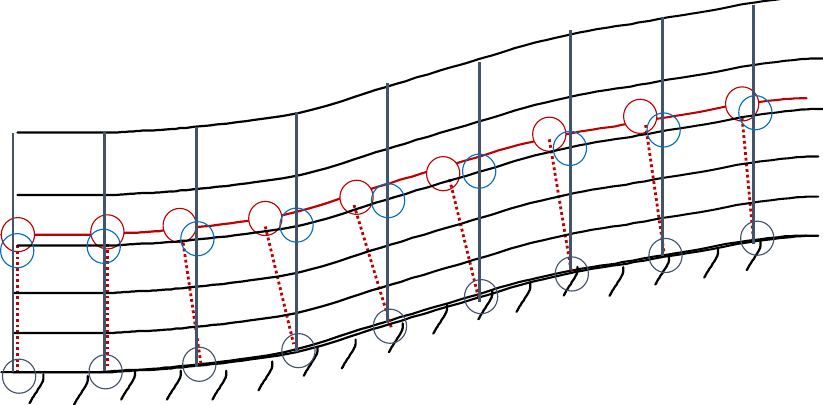
Figure 13. WA-WMLES: schematic depicting the LES mesh, with exchange layer (red curve), clos- est LES mesh points (blue circles), line segments for RANS ODEs integration (red dashed lines), and corresponding endpoints (black and red